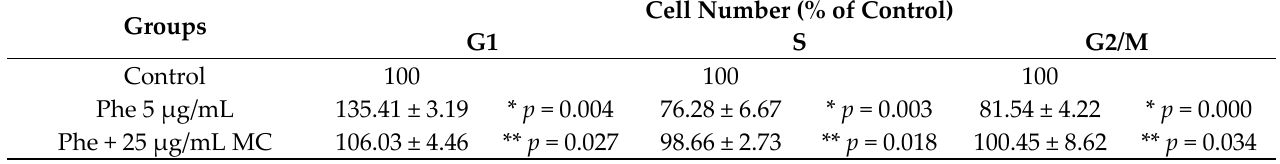
Figure 5. The effect of MC on PAHs-induced cell cycle arrest in HT-22 cells. ( a ) Representative histogram indicating cell cycle arrest, ( b ) cell number (% of control) in experimental group in each phase. * p < 0.05 vs. control (0 μ g/mL Phe); ** p < 0.05 vs. Phe alone. For G1 phase, * p value was 0.004 in 5 μ g/mL Phe alone, ** p value was 0.027 in Phe group combined with 25 μ g/mL MC. For S phase, * p value was 0.003 in 5 μ g/mL Phe alone, ** p value was 0.018 in Phe group combined with 25 μ g/mL MC. For G2 phase, * p value was 0.000 in 5 μ g/mL Phe alone, ** p value was 0.034 in Phe group combined with 25 μ g/mL MC. Compared with the control group, there was no significant difference in 25 μ g/mL MC group at all cell cycle phases ( n = 3).